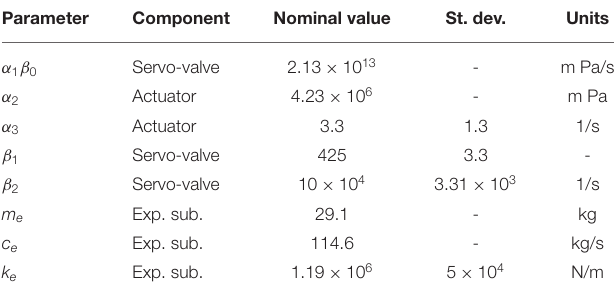
TABLE 3 | Parameter values for the control plant of Figure 5 .